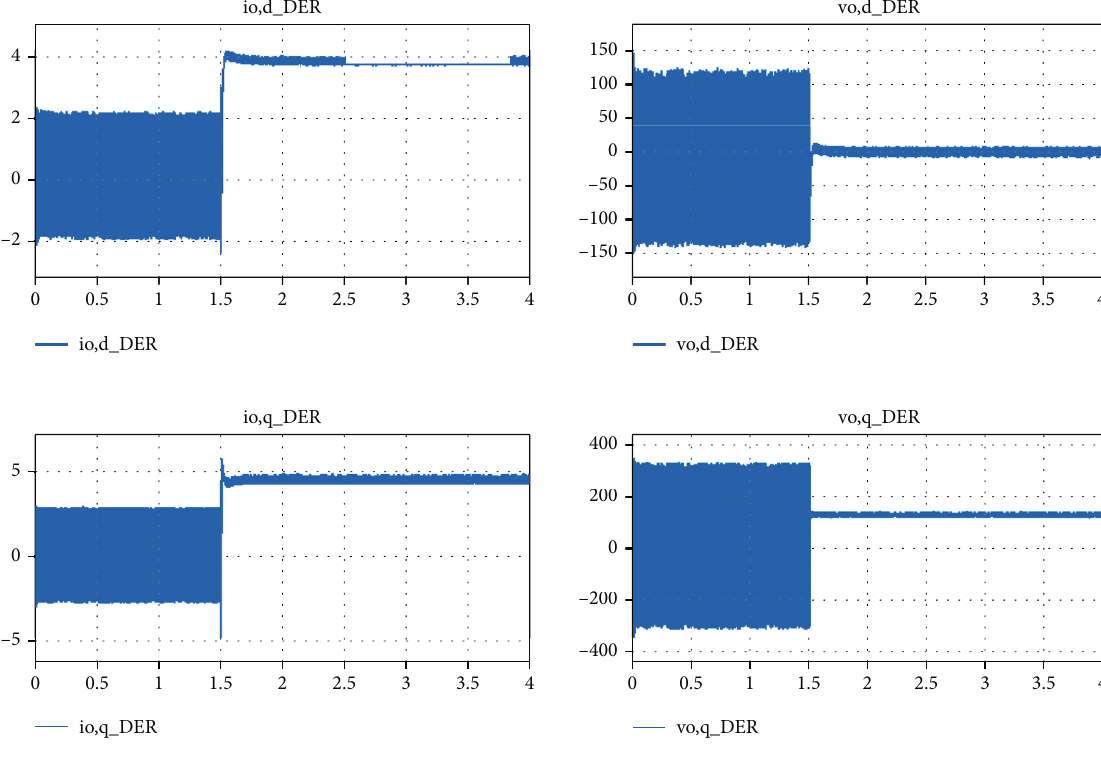
Figure 12: Photovoltaic Generators, Direct and Quadrature-voltage and current.